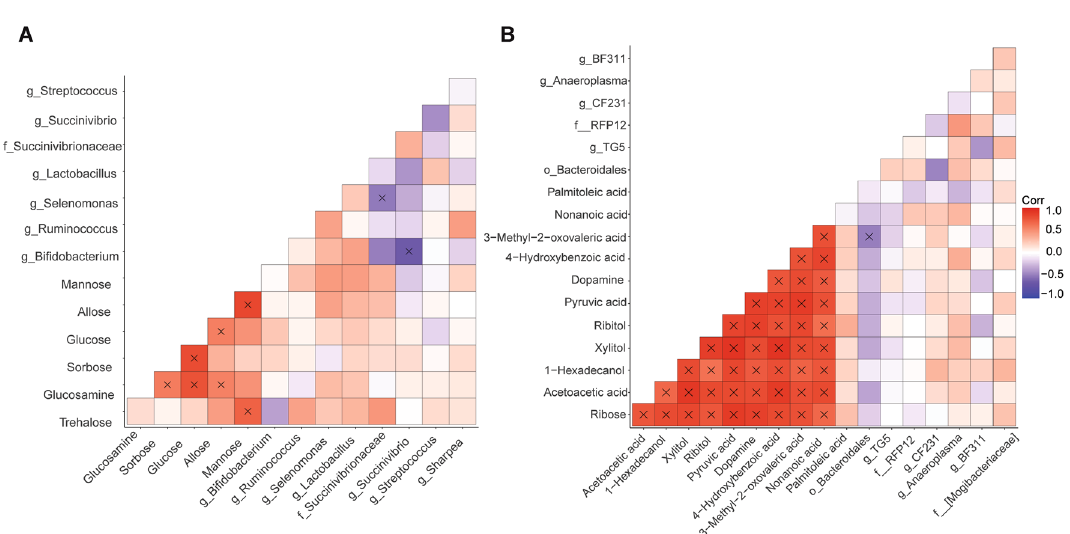
Figure 4. Spearman’s correlation of differentially expressed bacterial genera and metabolites detected in rumen fluid from lambs fed the ( A ) control or ( B ) carrot diet. Colour gradient of squares denotes a strong positive (red), strong negative (purple) or no (white) correlation, while “X” indicates a significant correlation ( P ≥